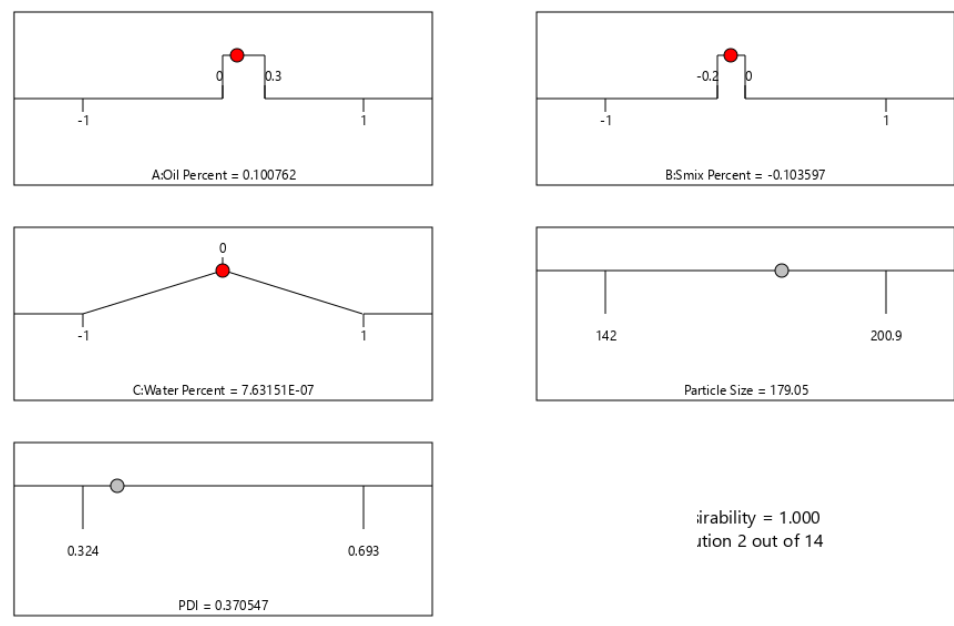
Figure 3. Numerical optimization data for ETB-NE by Box–Behnken design, showing the optimized values for independent factors and predicted values for the PS and PDI.